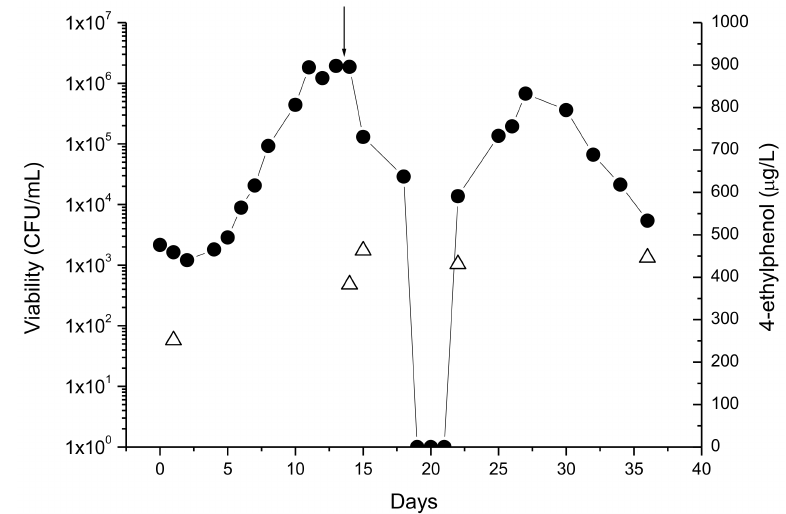
Figure 2. Effect of chitosan on the viability of growing cells D. bruxellensis ( • ) and on 4-ethylphenol ( (cid:52) ) production. Arrow: moment of chitosan addition. Absence of viable cells (CFU <1/mL) is indicated as 1 CFU/mL due to the logarithmic scale of the y -axis.